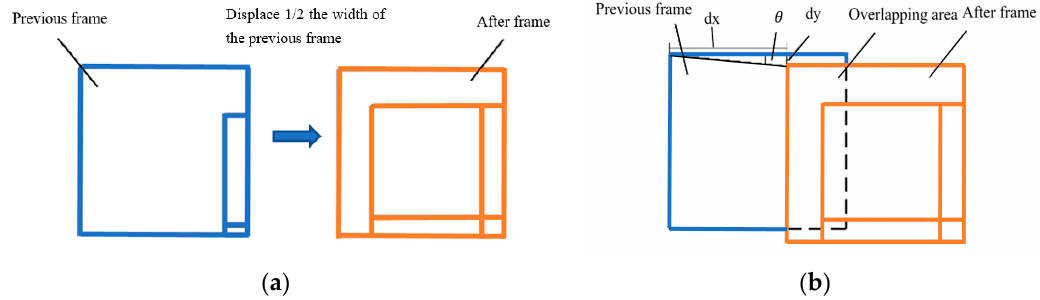
Figure 6. Image stitching schematic diagram. ( a ) Two adjacent images, ( b ) Image stitching.